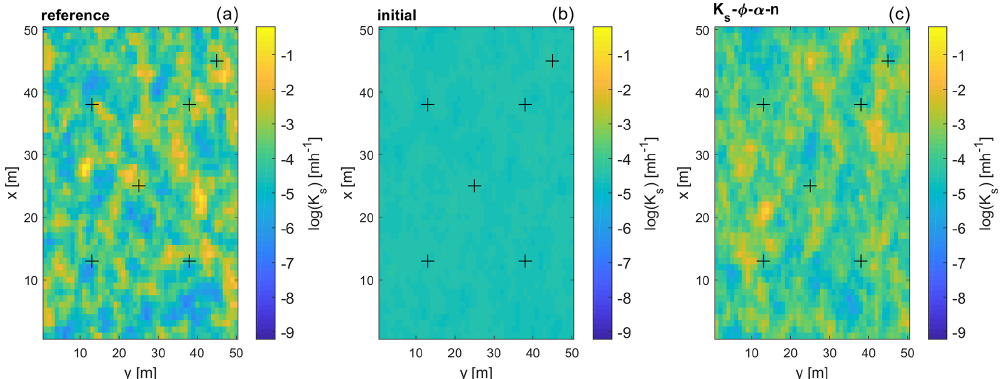
Figure 13. Horizontal cut of the saturated hydraulic conductivity field at z 2 = 0 . 75m below the surface for the reference run, the initial ensemble, and the estimated field when updating all parameters. The crosses denote the locations of the observation and validation boreholes. Note that panels (b) and (c) are ensemble means.